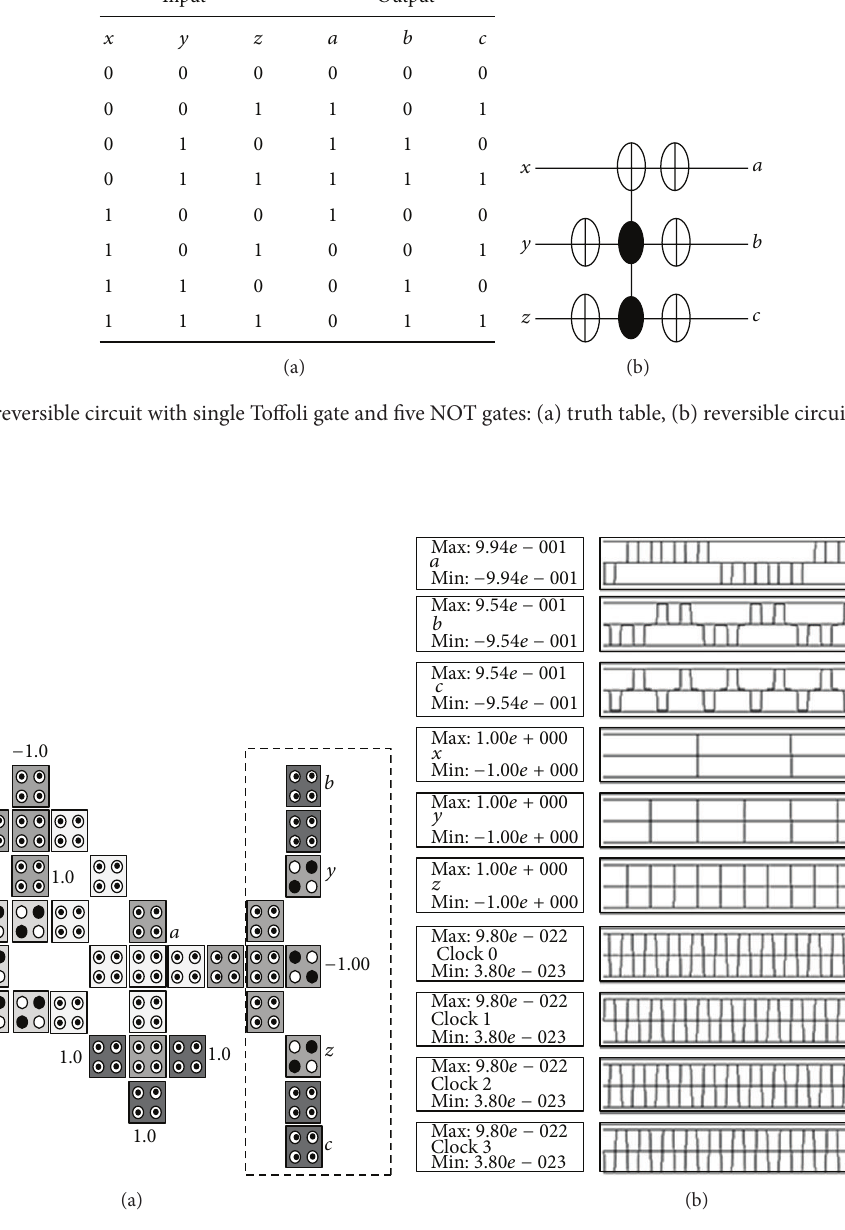
Figure 15: The proposed QCA for the reversible circuit shown in Figure 14: (a) the layout where the added cells to the basic building block are highlighted with dashed line, (b) the simulation